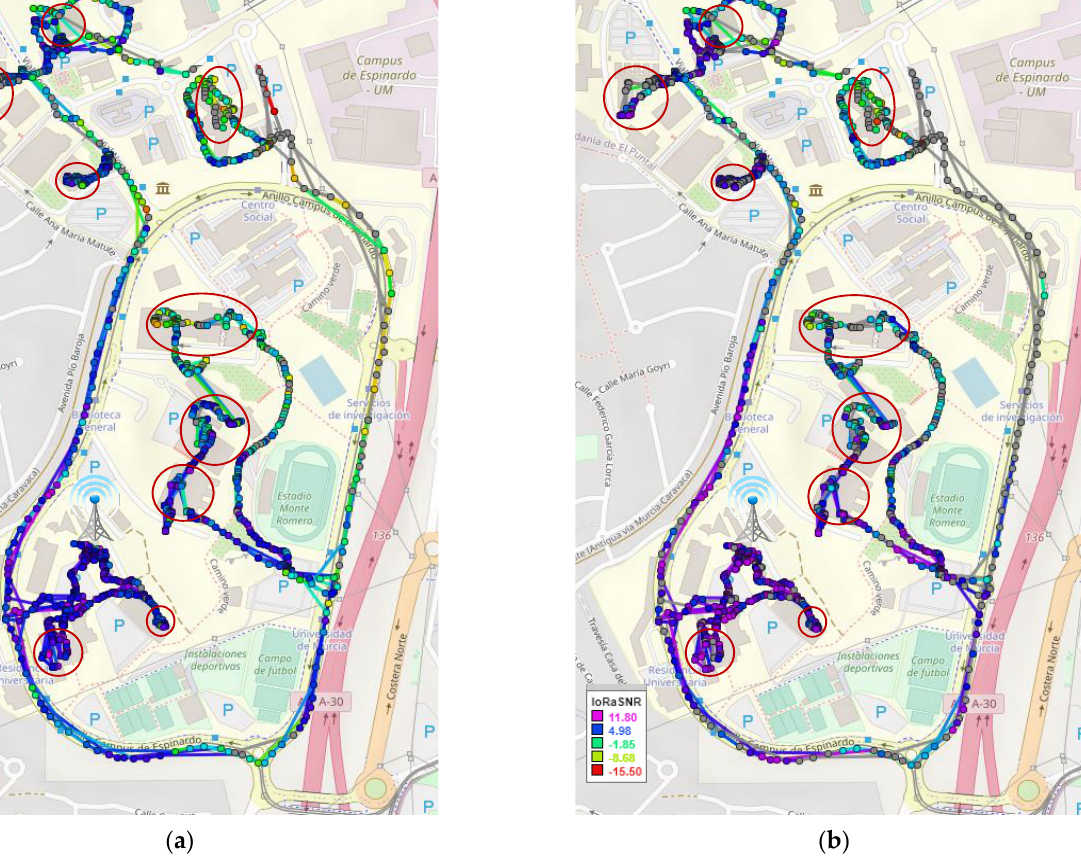
Figure 6. LoRaWAN SNR inside the campus: ( a ) uplink transmissions; ( b ) downlink transmissions. Table 1. Packet delivery ratio (PDR) in indoor and outdoor locations.